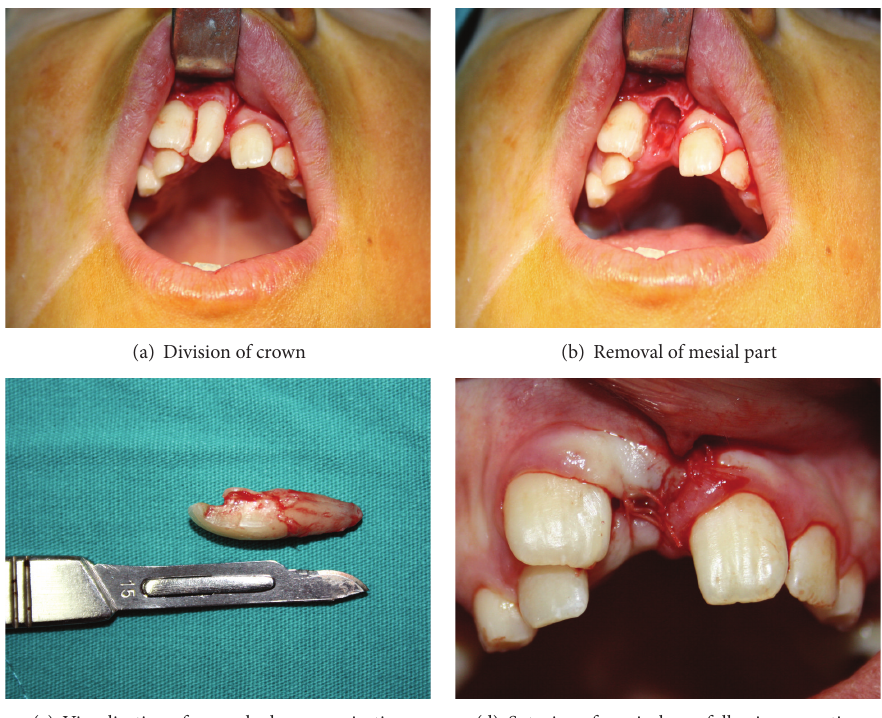
Figure 3: Surgical